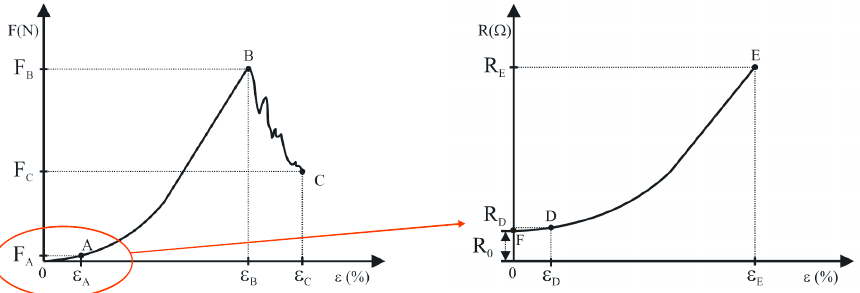
Figure 2. Characteristic diagrams of the tensile force–elongation (F- ε ) curve of the woven fabric and the electrical resistance–elongation (R- ε ) curve of the conductive fabric yarn. The yarns in the fabric are arranged in a wavy shape. Due to the corrugation of the yarns, the fabric behavior in the elongation at the warp and the weft will consist of a range that mainly occurs due to the correction of the corrugation of the yarns and a range that results from the elongation of the yarns themselves. The final elongation at the break of F